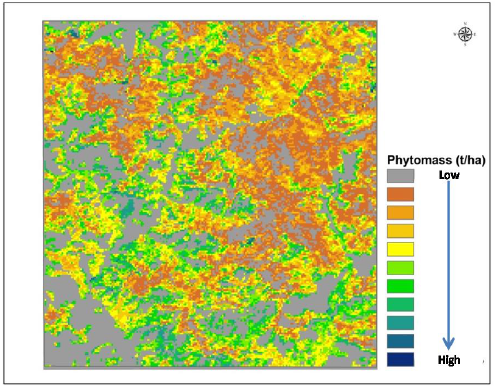
Figure 6. Satellite derived phytomass map of 250 m